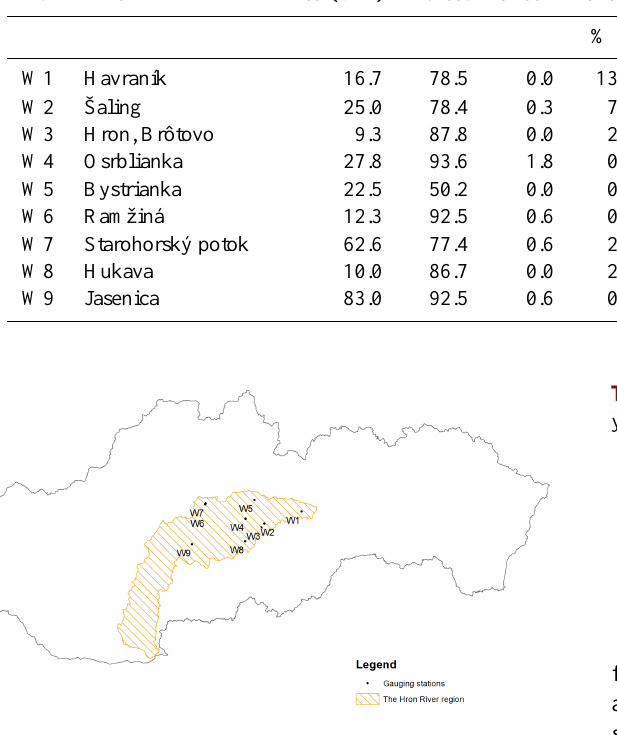
Figure 1. Location of the selected small watersheds within the Up- per Hron River basin, Slovakia.